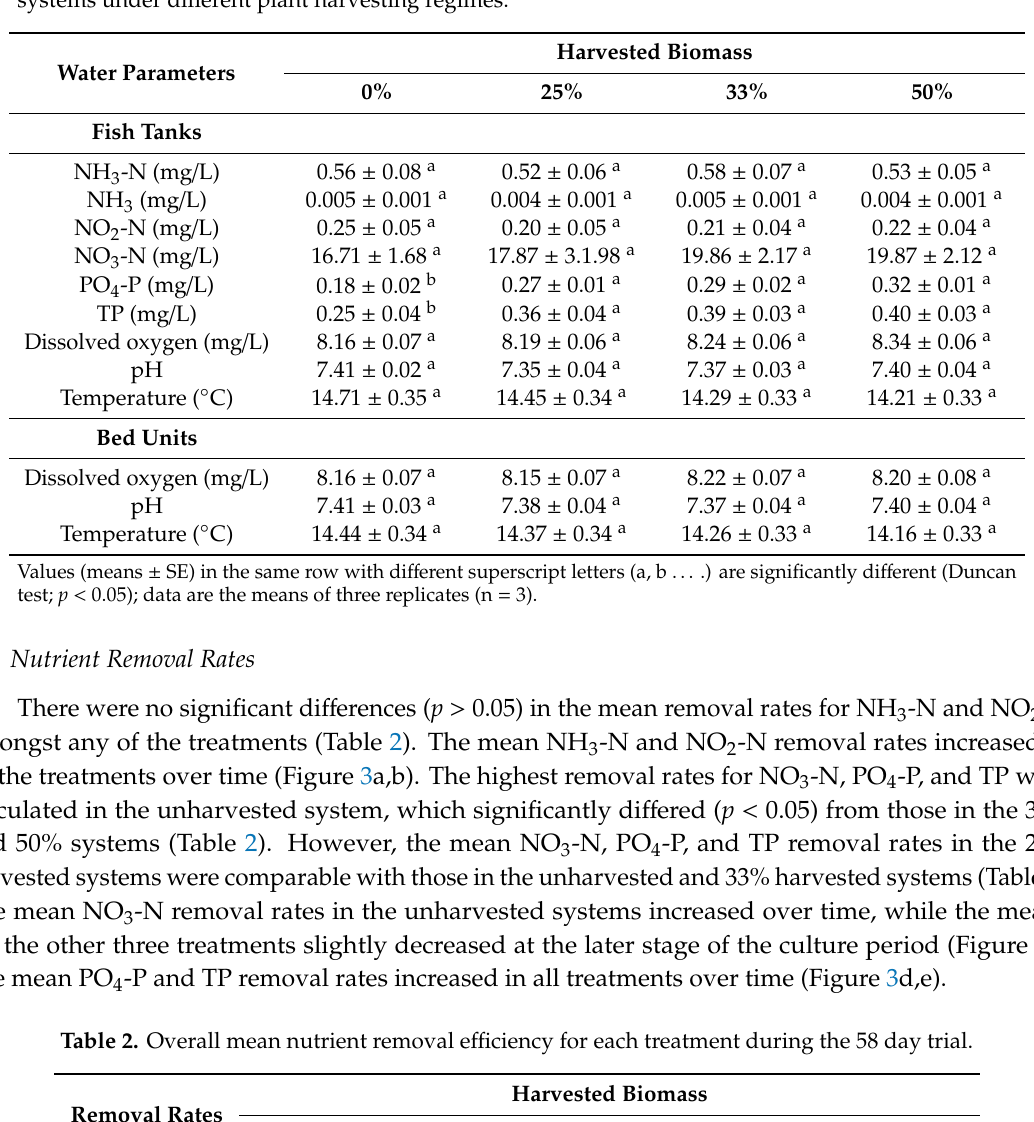
Table 1. Overall mean water quality parameters in the fish tanks and hydroponic units of aquaponic systems under di ff erent plant harvesting regimes.